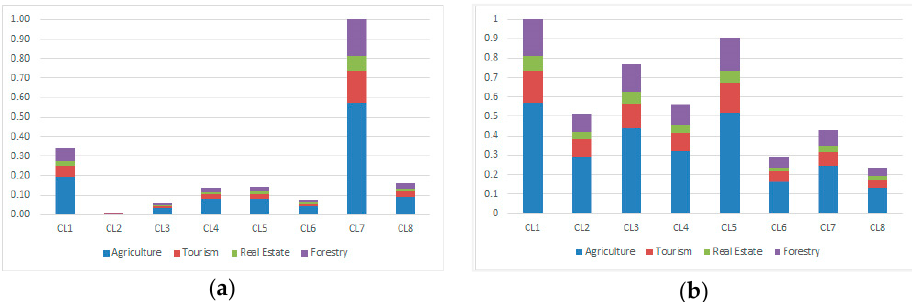
Figure 4. Landscape economic attractiveness index (LEA) (a) and specific landscape economic attractiveness index (SLEA) (b) for the LRM landscape (elaboration from Assumma et al., 2019).